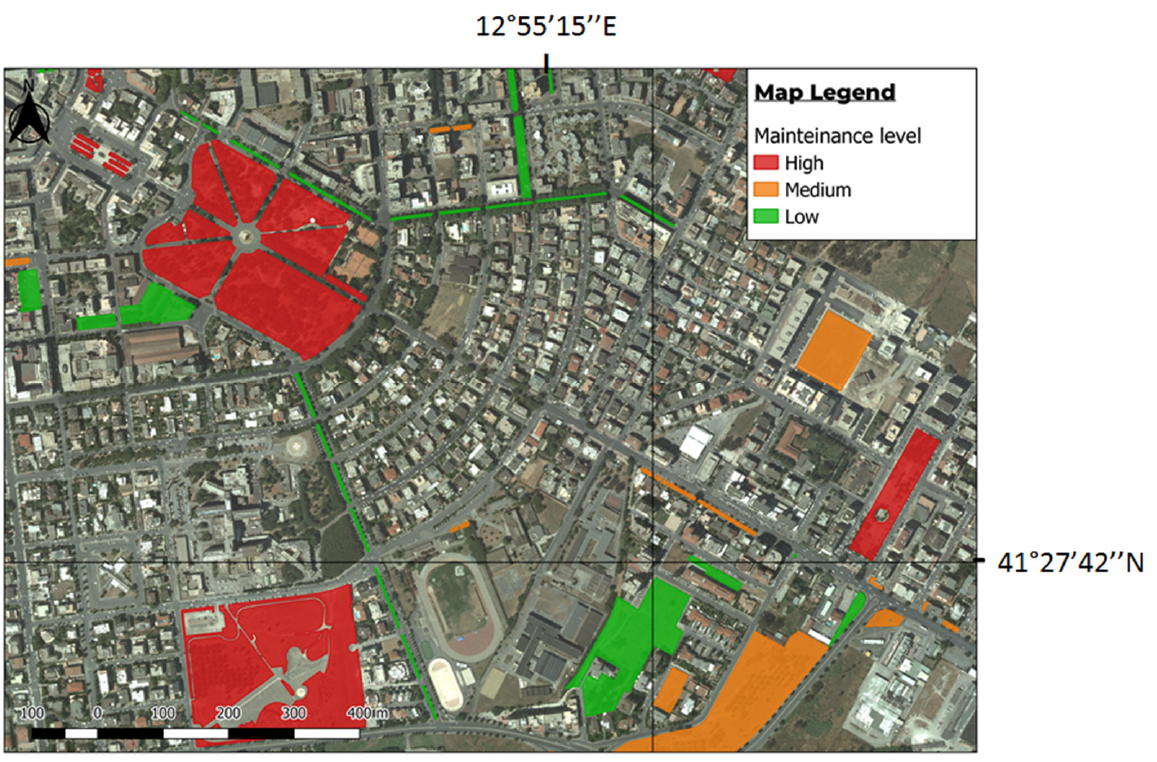
Figure 7. Classification of Urban Open Spaces according to the high (red), medium (yellow), and low (green) maintenance level in the city center of Latina.